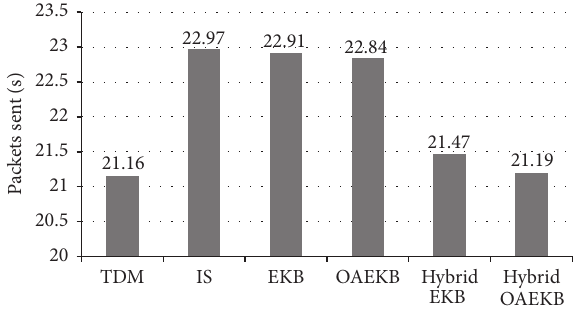
Figure 13: Comparison of packets sent per second.